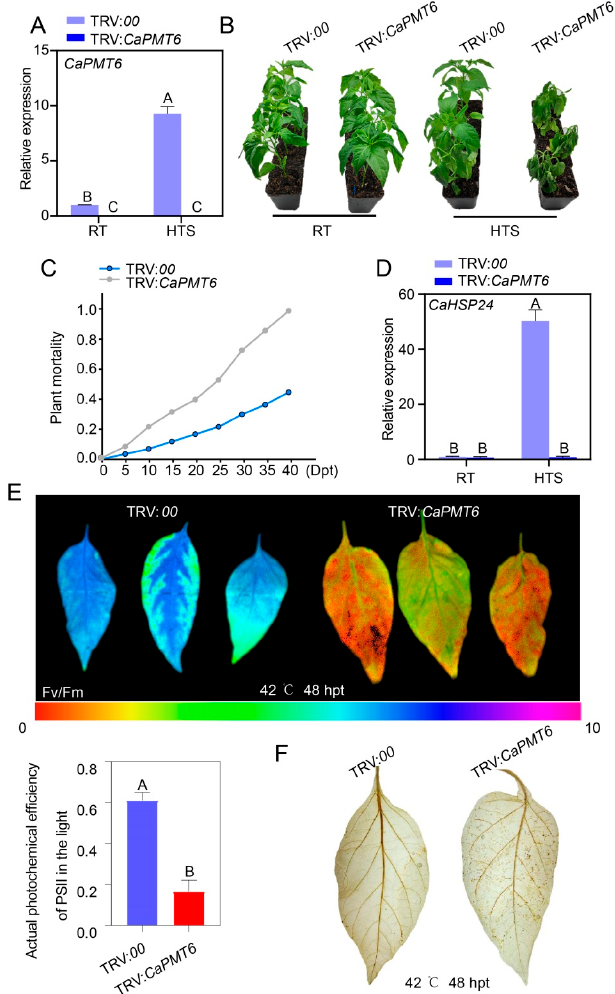
Figure 5. CaPMT6 silencing reduced pepper thermotolerance. ( A ) The success of CaPMT6 silencing by virus-induced gene silencing (VIGS) by measuring the transcript level of CaPMT6 in RT and HTS-challenged TRV: CaPMT6 pepper plants at 24 h post treatment (hpt). The transcript levels of TRV: 00 /RT was set to 1. ( B ) TRV: CaPMT6 pepper plants exhibited reduced thermotolerance com- pared with the wild type control plants. ( C ) TRV: CaPMT6 pepper plants exhibited higher mortality upon HTS compared with the wild type plants; a total of 20 plants were calculated. ( D ) The relative transcript level of CaHSP24 in TRV: CaPMT6 pepper plants was significantly lower than that in TRV: 00 pepper plants; CaActin was used as an internal control; the transcript levels of TRV: 00 /RT was set to 1. ( E ) HTS-challenged TRV: CaPMT6 pepper plants exhibited reduced optimal/maximal photochemical efficiency of PSII in the dark (Fv/Fm) and reduced actual photochemical efficiency of PSII in the light ( Φ PSII ) compared with TRV: 00 plants. ( F ) Higher level of H 2 O 2 accumulation displayed by darker DAB staining was found in the TRV: CaPMT6 pepper plants compared with TRV: 00 pepper plants. In ( A , D , E ), data are shown as means ± standard error of eight replicates;